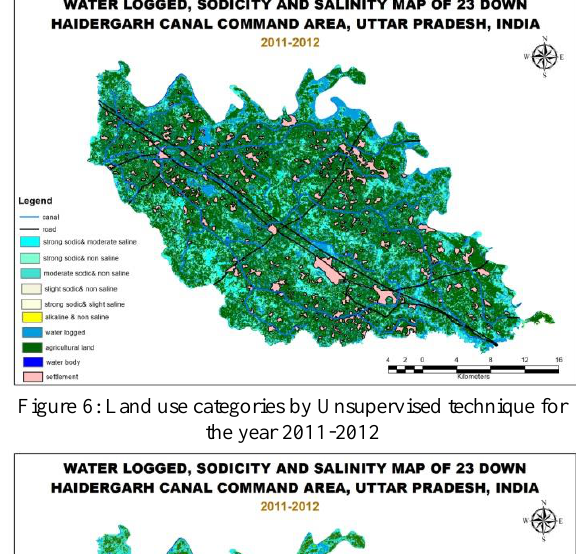
Figure 6: Land use categories by Unsupervised technique for